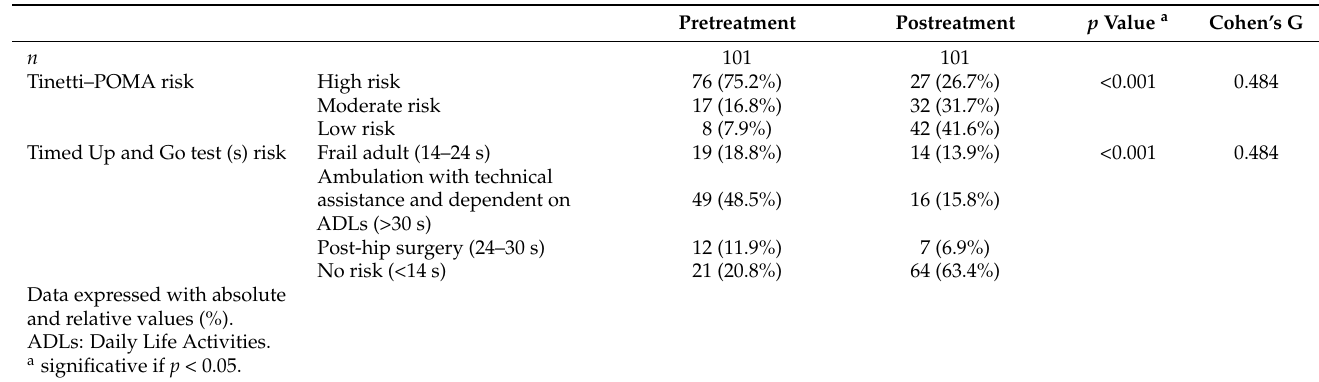
Table 4. Risk of